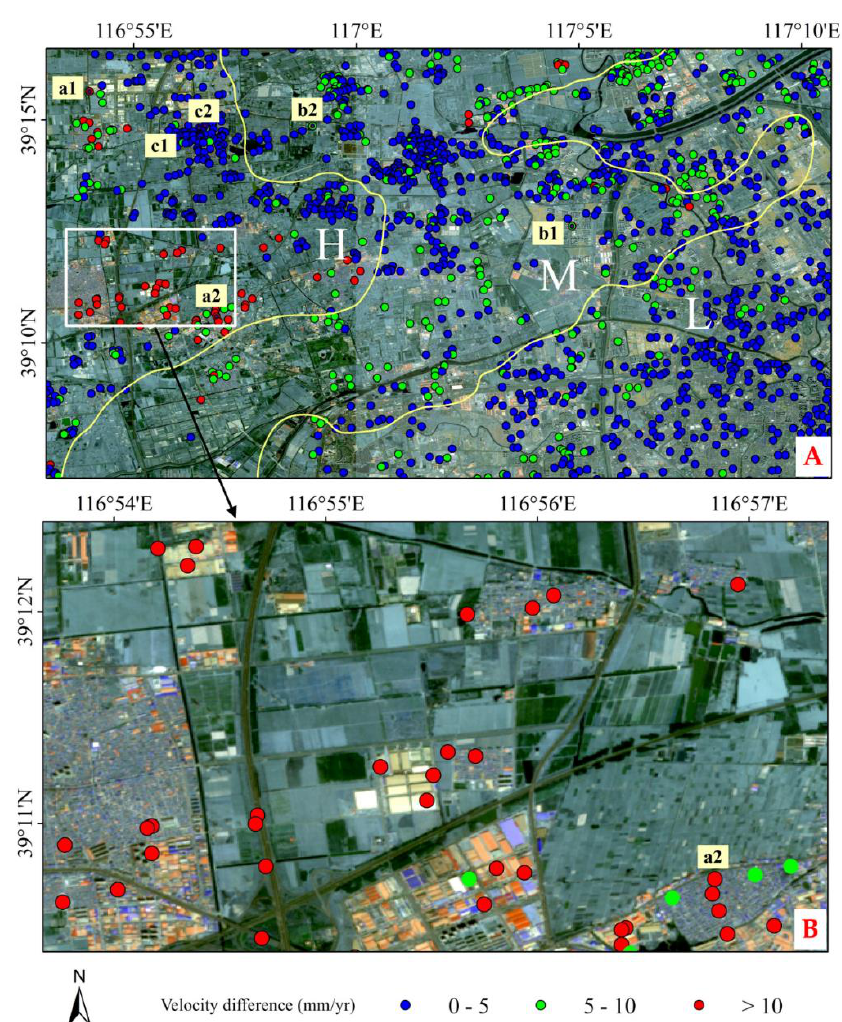
Figure 9. ( A ) Distribution of the corresponding points in the classes 0–5, 5–10 and > 10 mm/year, according to the velocity difference between PS and SBAS values, superimposed on the Sentinel-2A images. Six corresponding points (a1–c2) located in the high and medium subsidence areas have been indicated; ( B ) zoom on corresponding points with a large velocity difference (> 10 mm/year); most of these points are distributed in the high subsidence area.